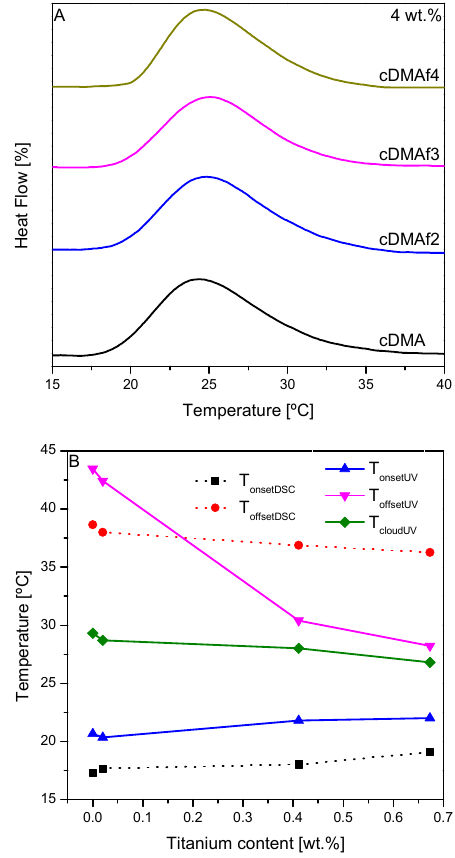
Figure 4. Phase transition temperatures associated with lower critical solution temperature (LCST), analyzed by calorimetry ( A ), and a comparison of calorimetric and UV results ( B ) for all polymeric solutions (4 wt.%).